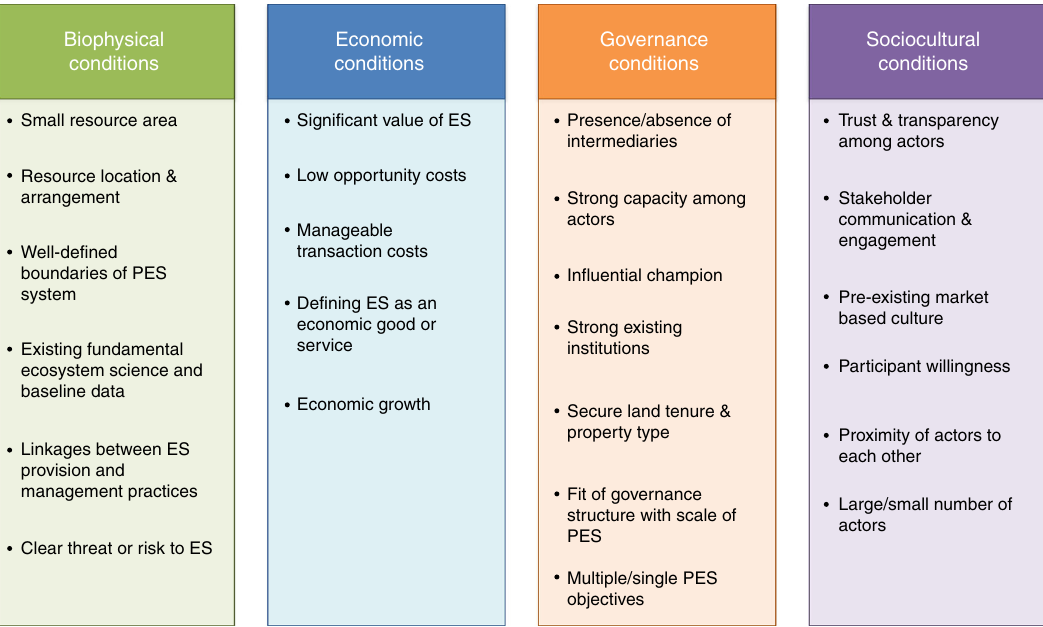
Fig. 1 Framework for enabling conditions for payments for ecosystem services (PES) programs identi fi ed from the literature (Huber-Stearns et al., Fig.